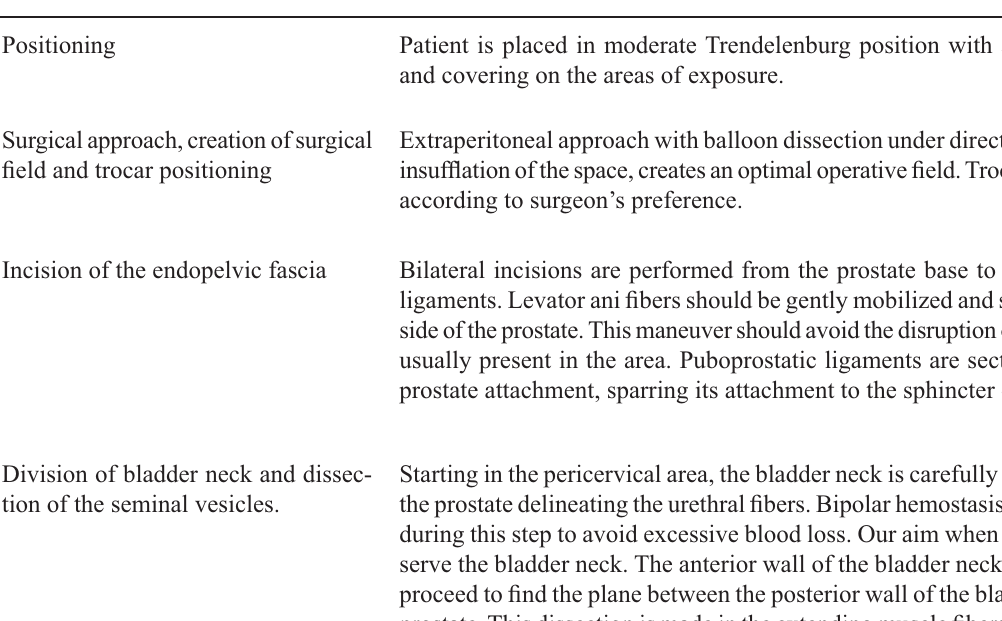
Table 3 – Montsouris technique for laparoscopic radical